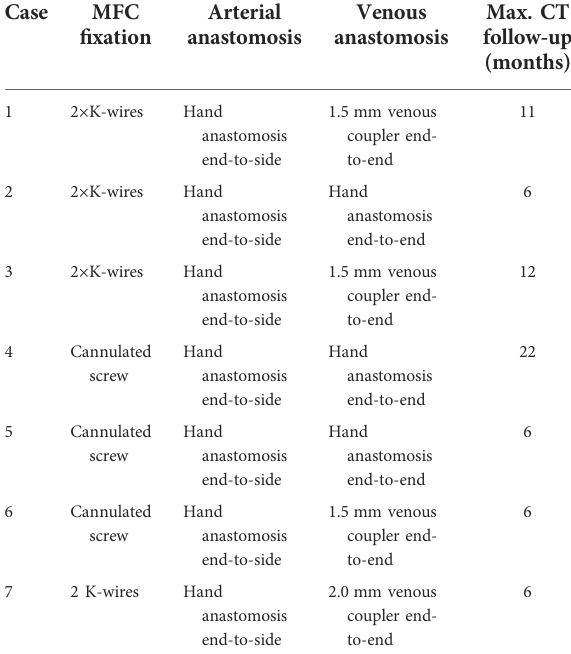
TABLE 2 Intraoperative details of the